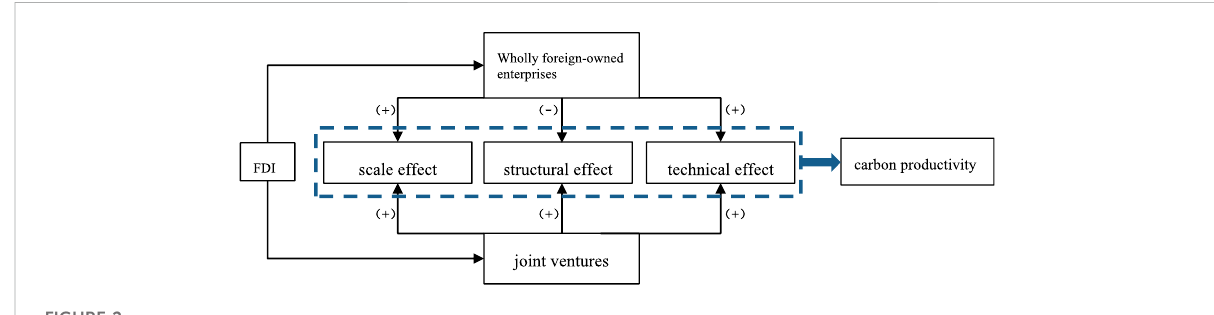
FIGURE 2 The in fl uencing mechanism of FDI on carbon productivity under different entry